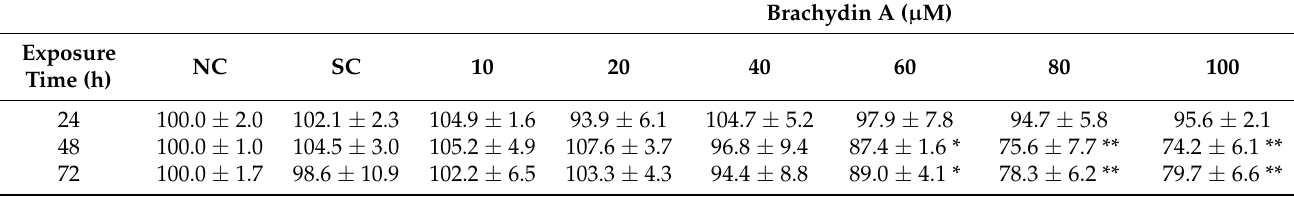
Table 1. Cell viability (%) of DU-145 spheroids after 24, 48, and 72 h of exposure with Brachydin A (BrA) and their respective controls, as assessed using the acid phosphatase assay 1 .